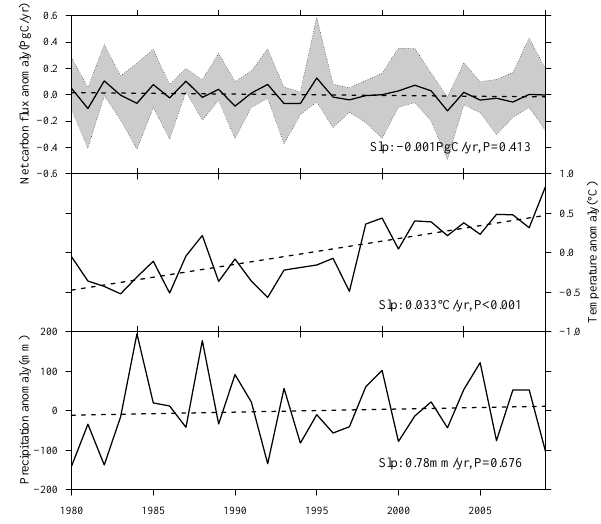
Fig. 4. Interannual variations in net carbon flux (top panel), annual temperature (middle panel) and annual precipitation (bottom panel) Fig.4. Interannualvariationsinnetcarbonflux(toppanel),annualtemperature(middlepanel)andannualprecipitation(bottompanel)over SouthAsiafrom1980to2009. Dashedlinesshowtheleastsquaredlinearfitwithstatisticsshownintext. Greyareainthetoppanelshows over South Asia from 1980 to 2009. Dashed lines show the least therangeofnetcarbonfluxanomaliesestimatedbytheelevenecosystemmodels. squared linear fit with statistics shown in text. Grey area in the top panel shows the range of net carbon flux anomalies estimated by the eleven ecosystem